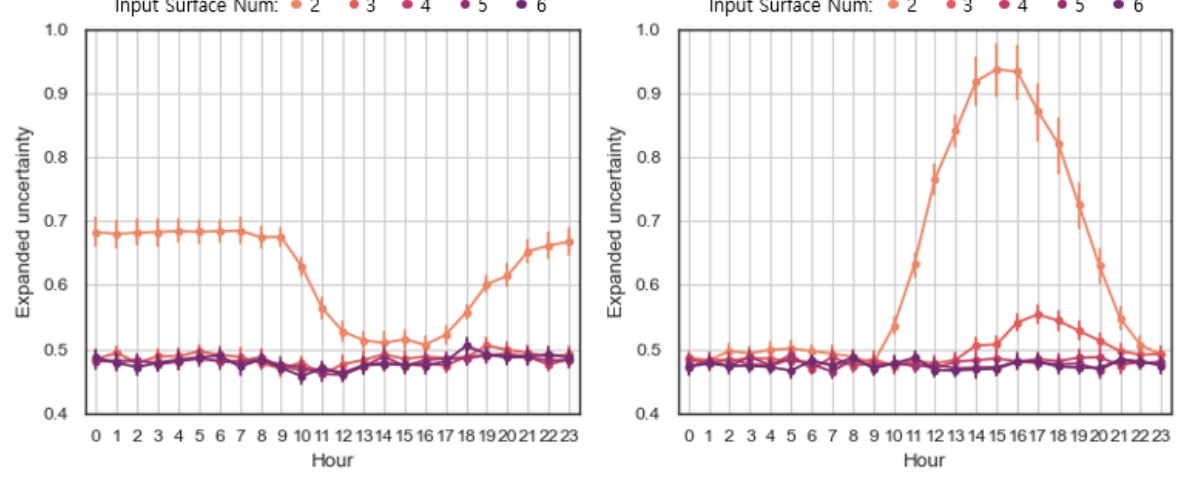
Figure 12. Expanded uncertainty of MRT over 24 h: Winter ( left ), summer ( right ).